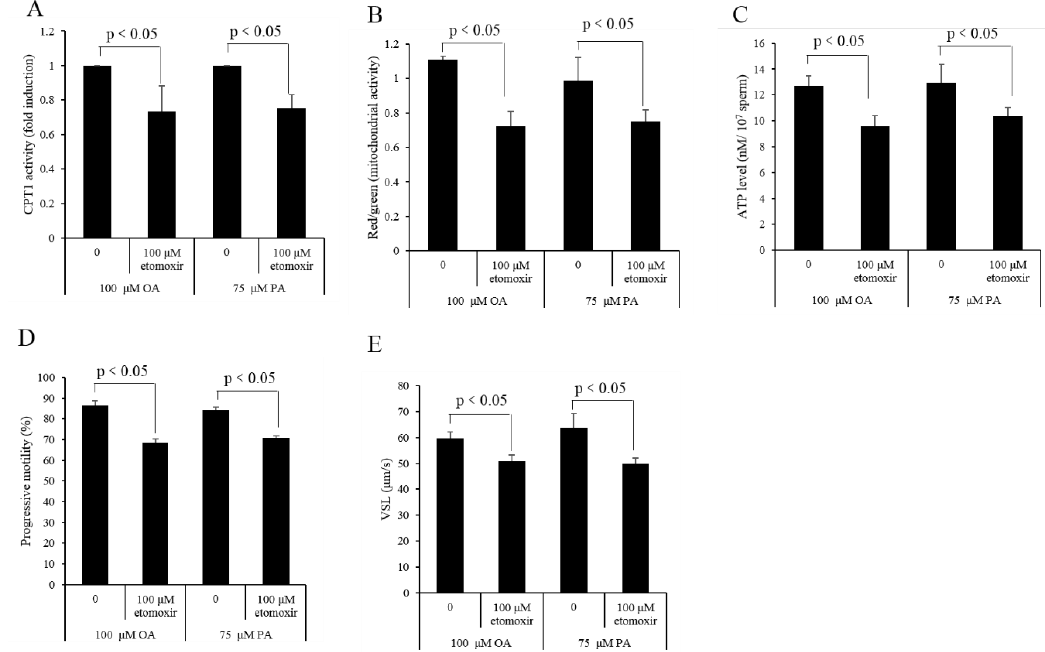
Figure 10. Sperm CPT1 activity ( A ), mitochondrial activity ( B ), ATP level ( C ), progressive motility ( D ), and VSL ( E ) were decreased by the addition of etomoxir to the medium in the presence of OA or PA. Data are the mean ± standard deviation (SD). Columns with di ff erent lowercase letters di ff er significantly ( p < 0.05).